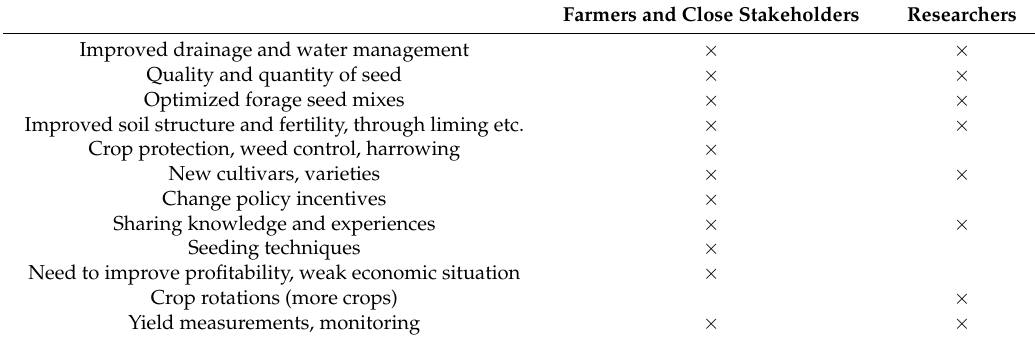
Table 4. Means for attaining higher crop yields expressed by farmers and close stakeholders of farmers (e.g., input suppliers, food industry, agricultural extension) and by researchers (right) in the workshops in 2014 and 2016. The responses listed first were most frequently mentioned by farmers and close stakeholders. Improved drainage was clearly the most frequently mentioned means for achieving higher yields, while there were only minor differences in how frequently other means were mentioned. Farmers and Close Stakeholders Researchers Improved drainage and water management × × Quality and quantity of seed × × Optimized forage seed mixes × × Improved soil structure and fertility, through liming etc. × × Crop protection, weed control, harrowing × New cultivars, varieties × × Change policy incentives × Sharing knowledge and